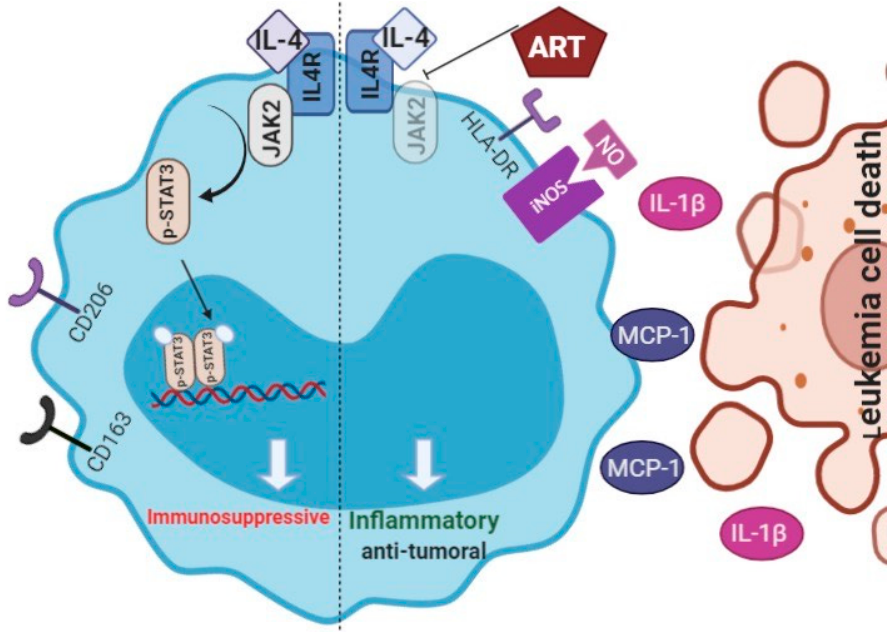
Figure 7. Hypothetic model of ART induction of monocyte phenotypic changes. In an immunosup- pressive environment, JAK2/STAT3 are activated after IL-4 release, which increases CD206 and CD163 expression, and decreases MCP-1/IL-1 β release and NO production. In contrast, ART inhibits activa- tion of JAK2/STAT3 pathway, increasing HLA-DR expression, NO production, and MCP-1/IL-1 β re- lease, and leads to an accumulation of monocytes with an inflammatory profile. In return, CD206, CD163, and CD16 expressions decrease. In co-culture with leukemic cells, monocytes-ART-pro- grammed assumed a tumoricidal profile and induces apoptosis of leukemic cell. These data suggest that ART switches monocytes to an inflammatory and antitumoral profile that could be useful for con- trol tumor progression and re-educates monocytes inside of a tumor